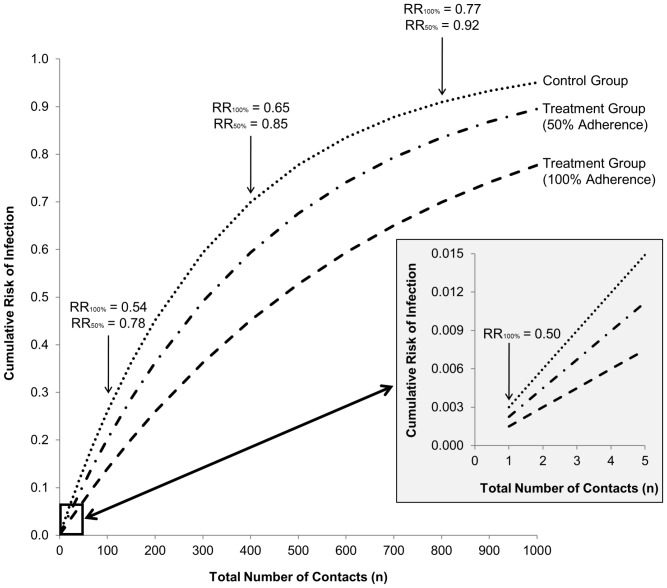
Cumulative risk of infection as a function of the number of unprotected contacts () with an HIV-infected partner for women in the control and treatment group for different levels of adherence to the intervention gel (RR100% and RR50% indicate the relative risk of infection for 100% and 50% adherence to the gel).